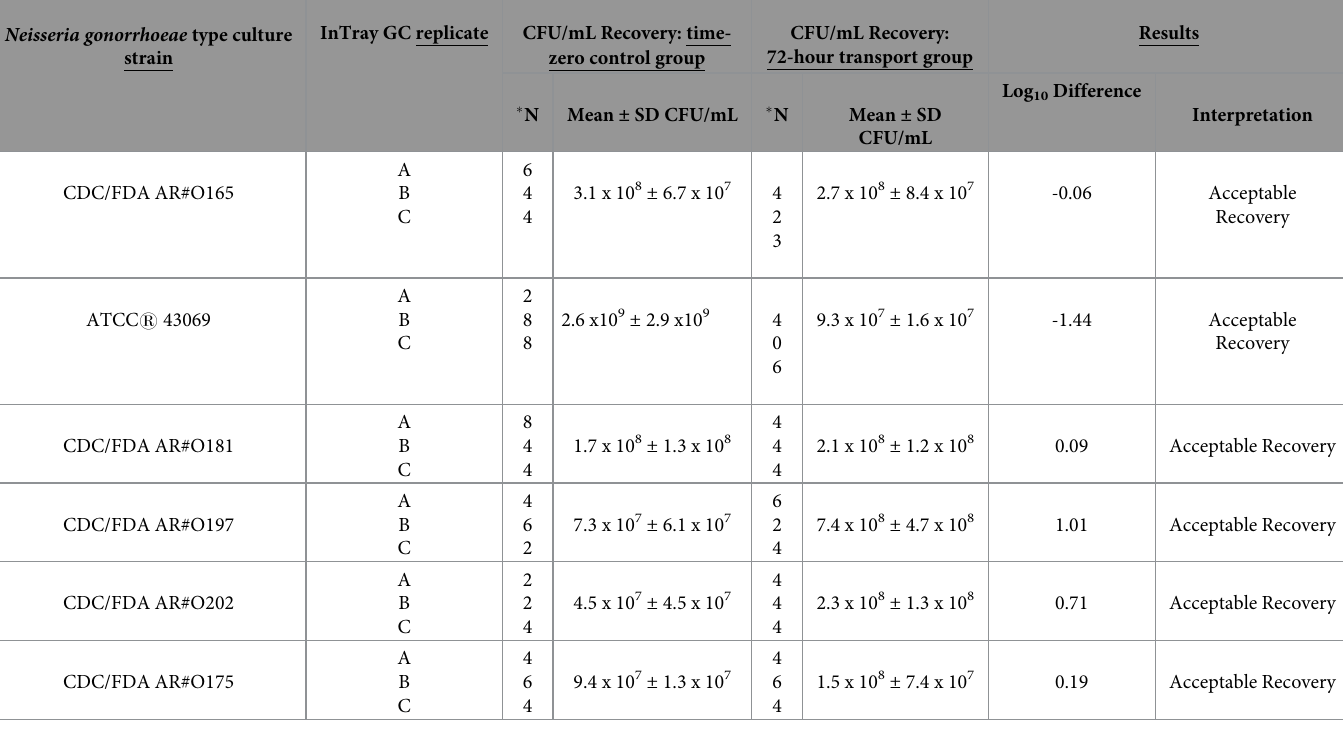
Table 1. Quantitative recovery results of the subject InTray GC transport device for six Neisseria gonorrhoeae type culture